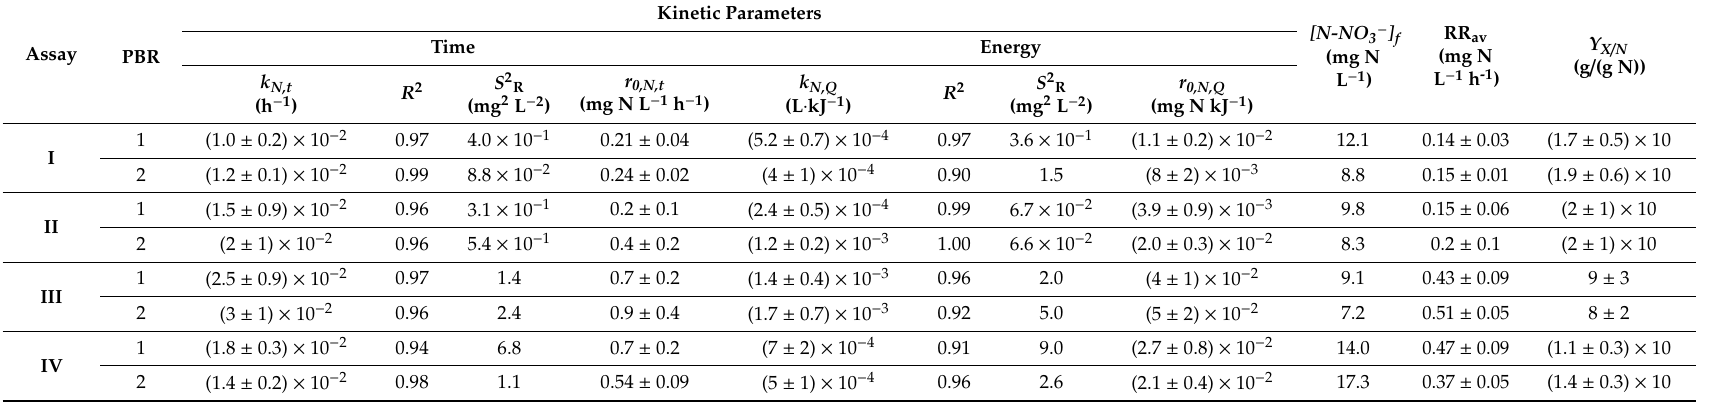
Table 3. Nitrogen removal kinetic parameters for all